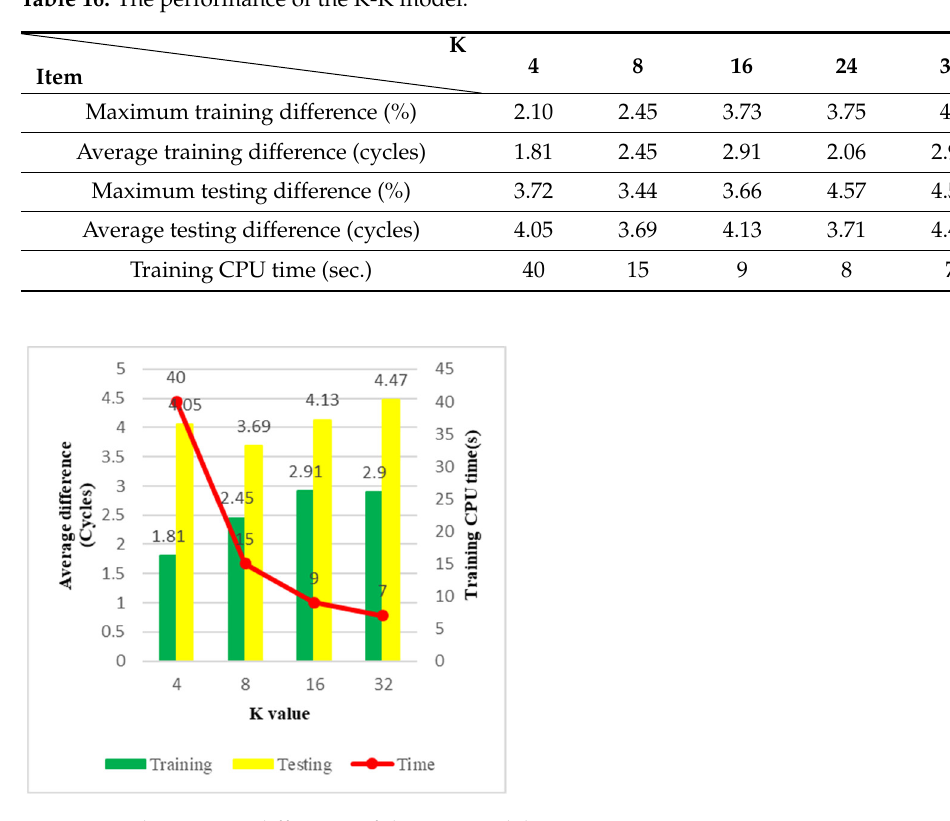
Figure 10. The average difference of the K-K model.